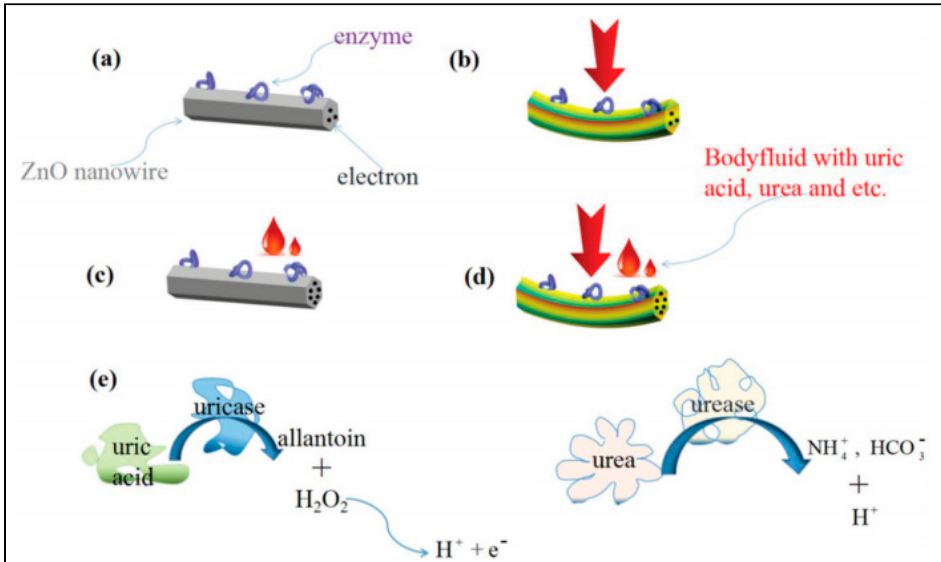
Figure 8. The working mechanism of a self-powered implantable e-skin. ( a ) Enzyme@ZnO nanowire in pure water without a compressive force. ( b ) The piezoelectric output of the enzyme@ZnO nanowire in pure water under an applied force. ( c ) Enzyme@ZnO nanowire in the corresponding solution without a compressive force. ( d ) The piezoelectric output of the enzyme@ZnO nanowire in a corresponding solution under an applied force. ( e ) The enzymatic reactions on the surface of the nanowire (reprint adapted with permission from Yang W et al., 2018; Ref. [224]. Copyright 2018 RSC Publisher).